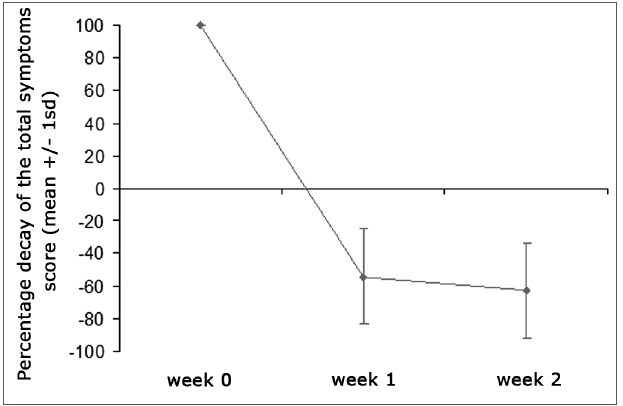
Table 3. Adverse reactions observed during the study